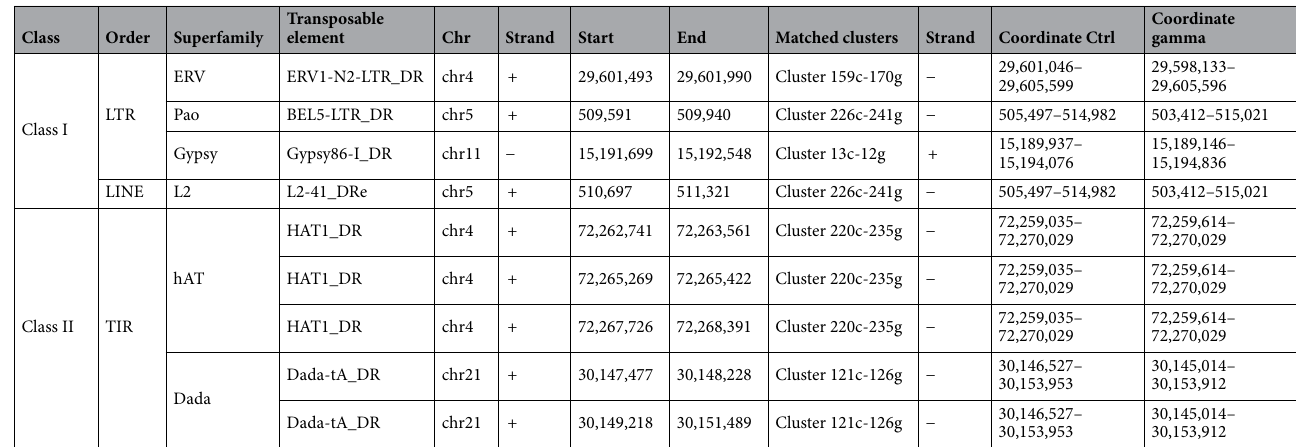
Table 4. Genomic association between DEpiRNA clusters and transposable elements (TE) in F 1 offspring from parents exposed to gamma radiation. Fisher’s exact test, p-value =